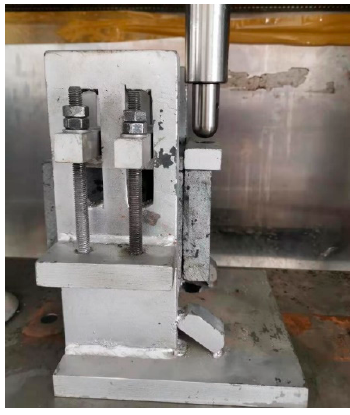
Figure 5. The process of the shear bond test.